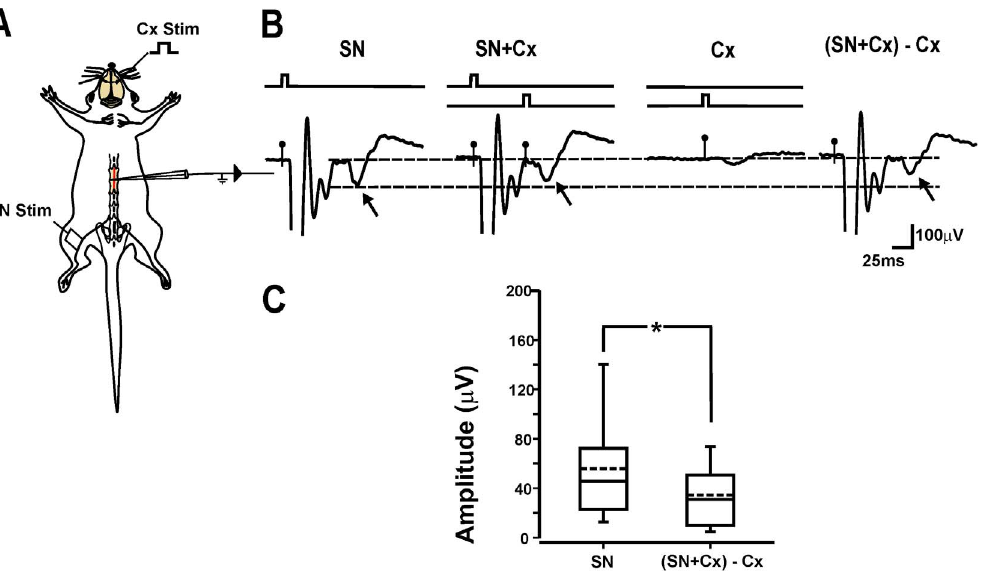
Figure 1. Sensorimotor cortex stimulation inhibits C–fiber dorsal horn EFPs. A, Schematic diagram of the experimental arrangement. B, electrophysiological recordings show: the averaged (n=16 sweeps) C–fiber EFPs (arrow) generated by stimulation of the sciatic nerve (SN) (first trace); averaged C–fiber EFP evoked by an SN stimulus preceded by cortical stimulation (Cx + SN) (second trace); Cortex–evoked potentials (Cx) (third trace); averaged C–fiber EFP preceded by cortical stimulation minus cortex–evoked potentials ((Cx + SN)–Cx) (fourth trace). C, box plot computed from the amplitudes of C–fiber EFPs evoked by SN stimulation alone and when C–fiber EFPs were preceded (25 to 100 ms) by cortical stimulation ((Cx + SN)– Cx). *p , 0.05, Wilcoxon test.